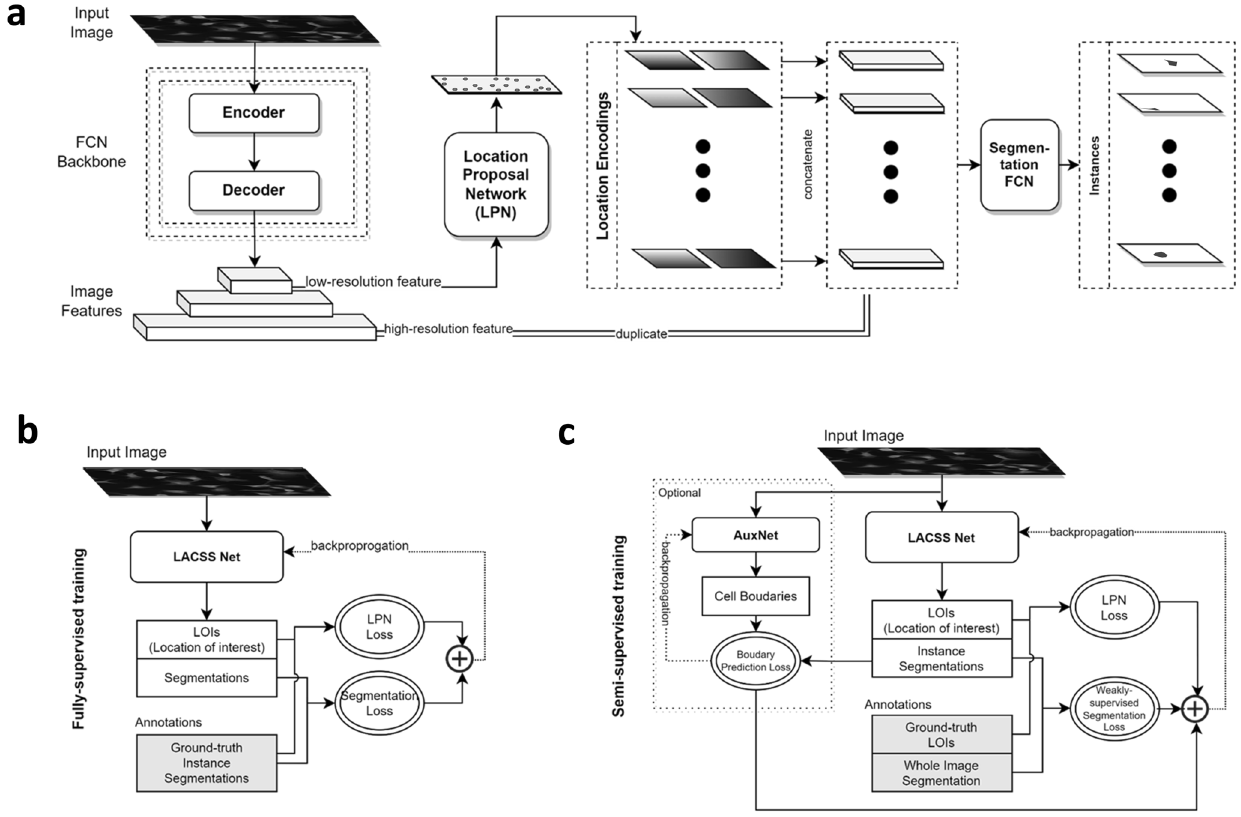
Fig. 2 LACSS model. a Model architecture showing all three components of the model: backbone, location proposal network (LPN) and segmentation FCN. b Schematic diagram of LACSS model training under full-supervision. c Schematic diagram of LACSS model training under